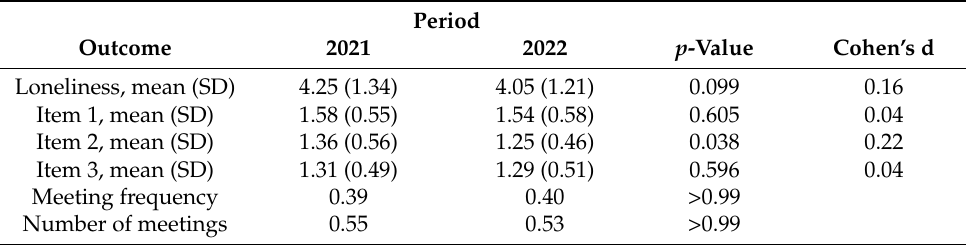
Table 3. Change in the degree of loneliness and the frequency and number of instances of meeting with friends or acquaintances. Period Outcome 2021 2022 p